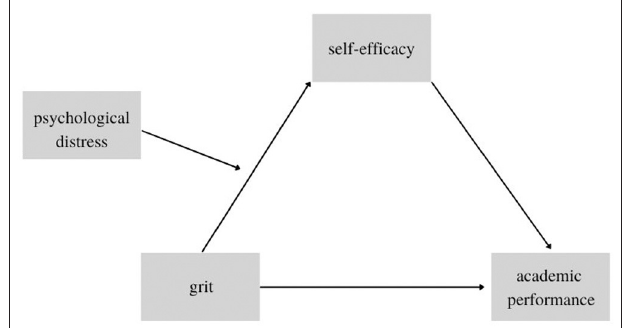
FIGURE 1 | Conceptual